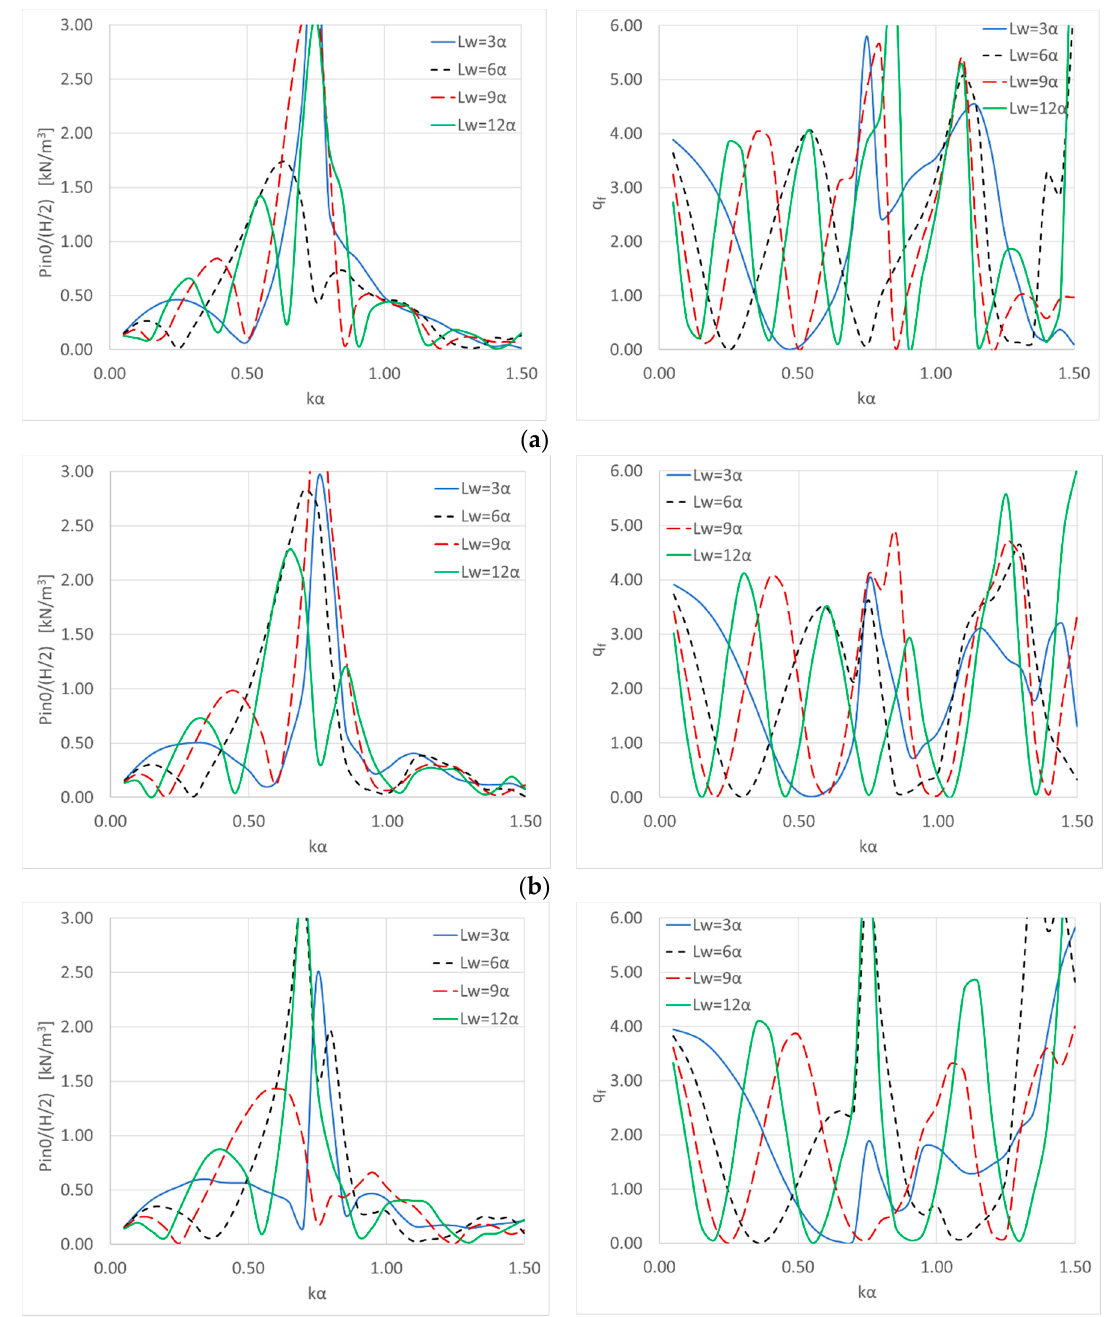
Figure 7. Air pressure inside the 1st OWC (left column figures) and array’s q f factor (right column figures) versus k α for various examined distances between the array and the breakwater and wave heading angles: ( a ) β = 0; ( b ) β = π /6; ( c ) β = π /4.